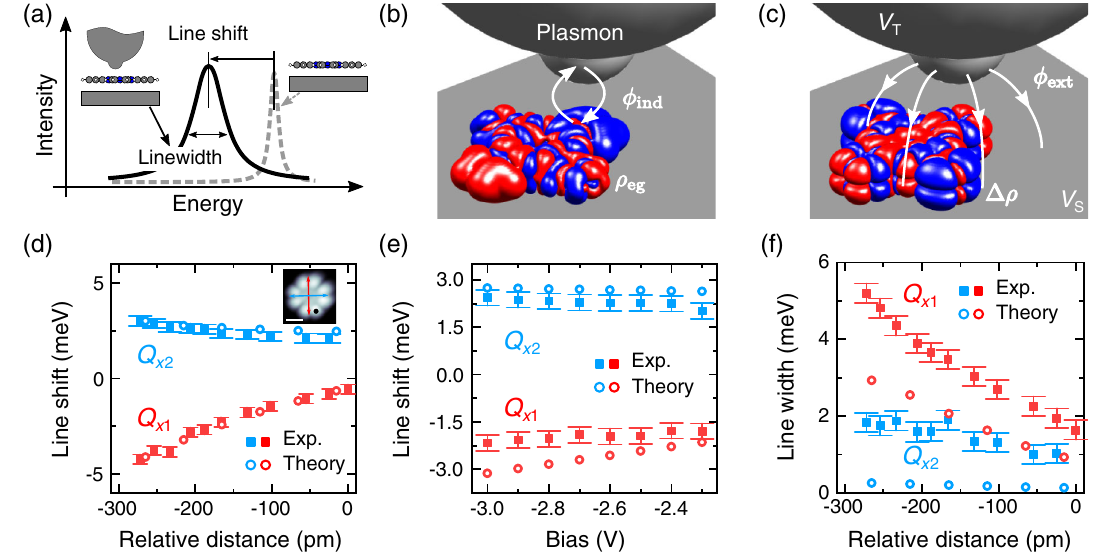
FIG. 2. Probing and calculating the dc Stark effect, Lamb shift, and Purcell effect in STML. (a) Schematic representation of the overall shift and broadening of the excitonic photon emission spectral line recorded in STML as the tip approaches the sample molecule. The two schemes show the systems used to model the STM junction; the molecule is separated from the substrate by a vacuum gap of r Þ induces a plasmonic response in the tip and the substrate, which thickness d ¼ 0 . 5 nm. (b) The excitonic transition charge density ρ eg ð is represented by the induced plasmonic potential ϕ . (c) Difference between the electron densities of the molecular electronic excited ind r Þ generated by the voltage state ( Q ) and the ground state. The charge density difference Δ ρ ð r Þ is exposed to the external potential ϕ x ext ð − V V ¼ V applied to the substrate and the tip of the microscope. Red and blue indicate negative and positive values, respectively. S T (d) Line shift as a function of the relative tip-sample distance ( V ¼ − 2 . 5 V). Inset: STM image V ¼ − 2 . 5 V; I ¼ 10 pA; scale bar, 1 nm. The black dot marks the position of the measurements in panels (d) – (f). The color arrows indicate the two dipoles. (e) Line shifts as a function of bias. The tip-sample distance is fixed during the measurement. The line shifts in panels (d) and (e) were calculated by taking 1 . 815 eV as a reference value. (f) Linewidths as a function of the relative tip-sample distance ( V ¼ − 2 . 5 V). The overall shifts (Lamb shift combined with the Stark shift) (d, e) and widths (f) of the excitonic emission lines experimentally recorded (full squares) are compared with the theoretical calculations (empty circles) obtained using the approach presented in panels (a) – (c). The data in panels (d) and (f) are extracted from the measurement shown in Fig.